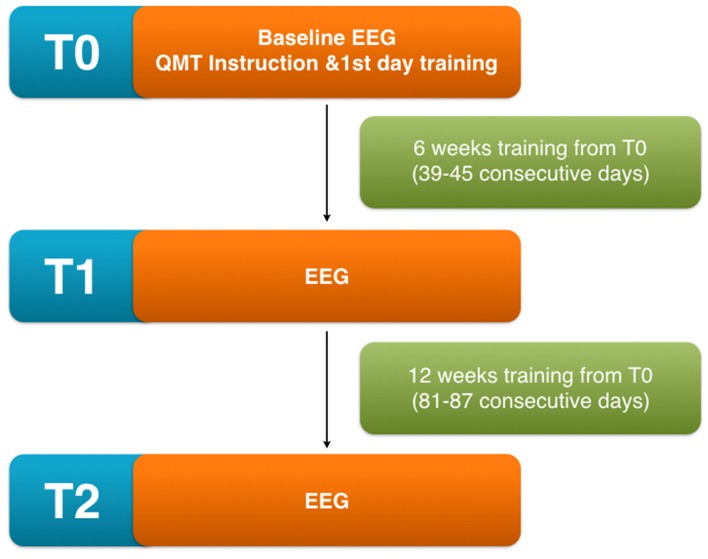
Scheme of the experimental protocol showing the different time points involved in the analysis T0 (before initiating quadrato motor training (QMT) training), T1 (after 6 weeks from the beginning), T2 (after 12 weeks from the beginning).